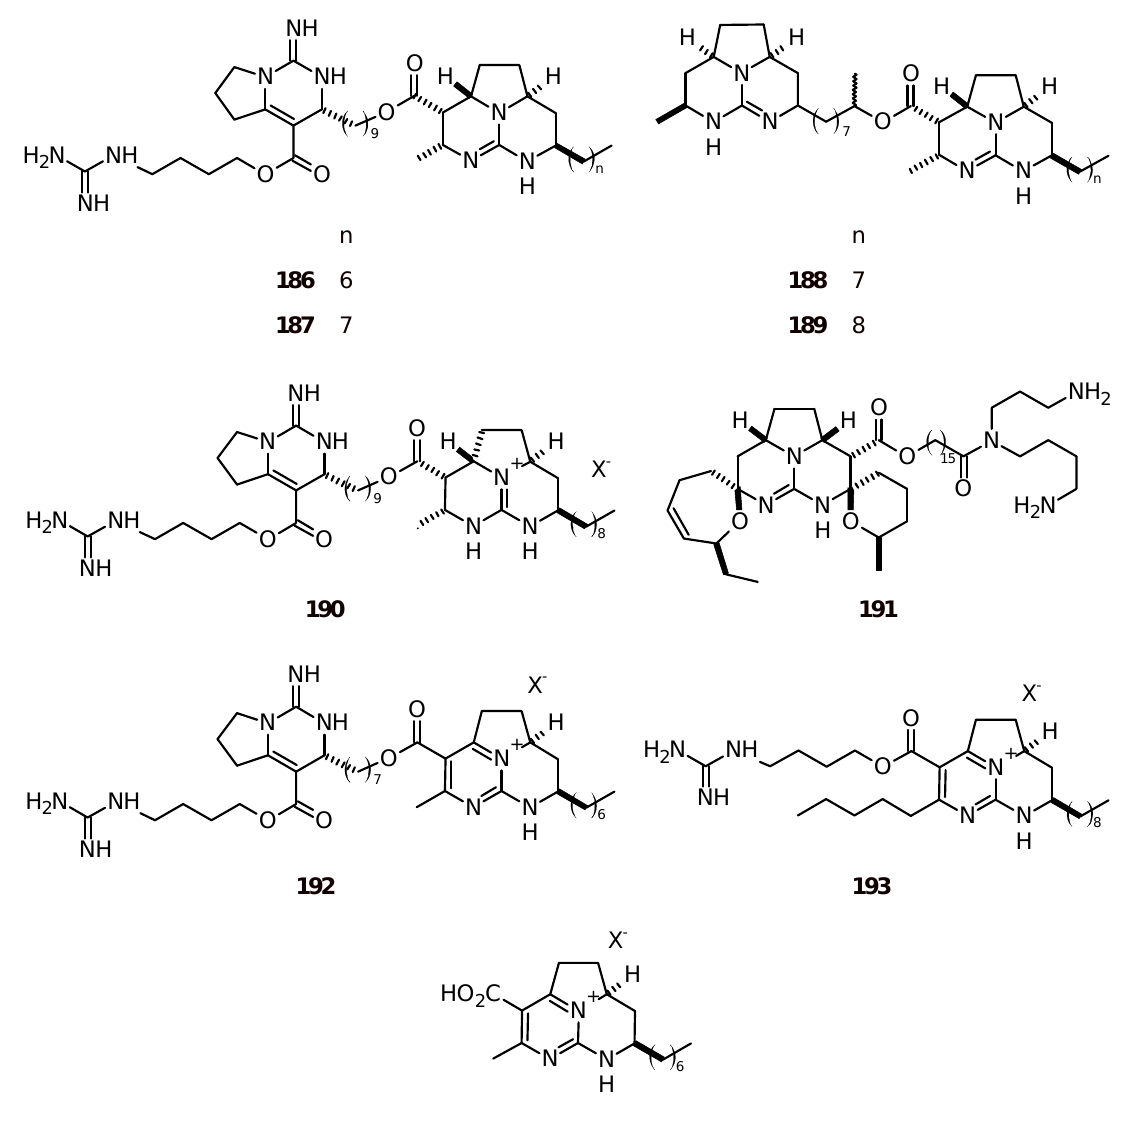
Figure 20. Structures of guanidine alkaloids